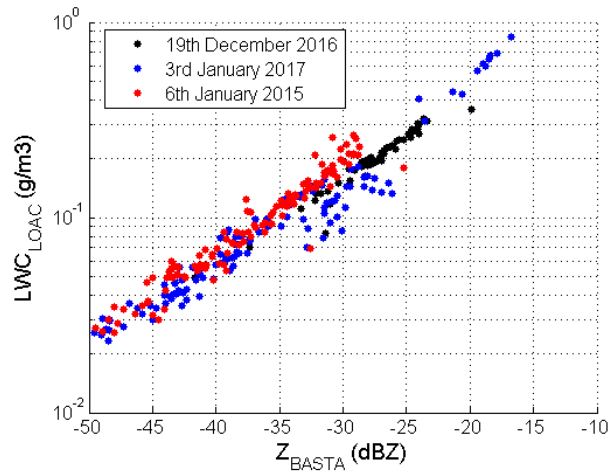
Figure 4. Relationship between liquid water content (LWC) measured with the LOAC sensor and radar reflectivity measured with BASTA for the three case studies (black markers for 19 December 2016, blue markers for 3 January 2017 and red markers for 6 January 2015).